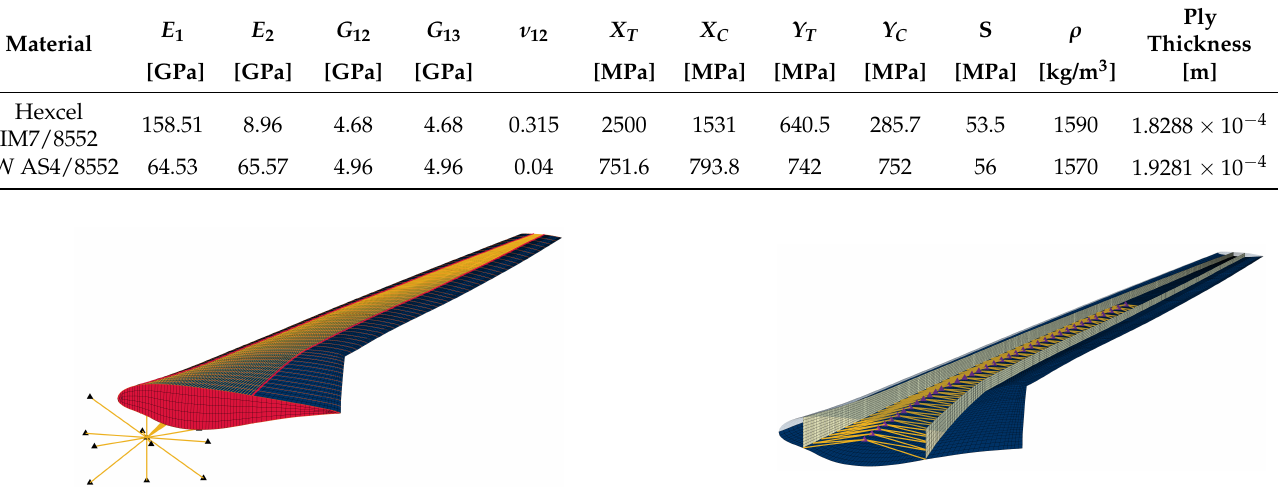
Table 5. Composite-materials properties.